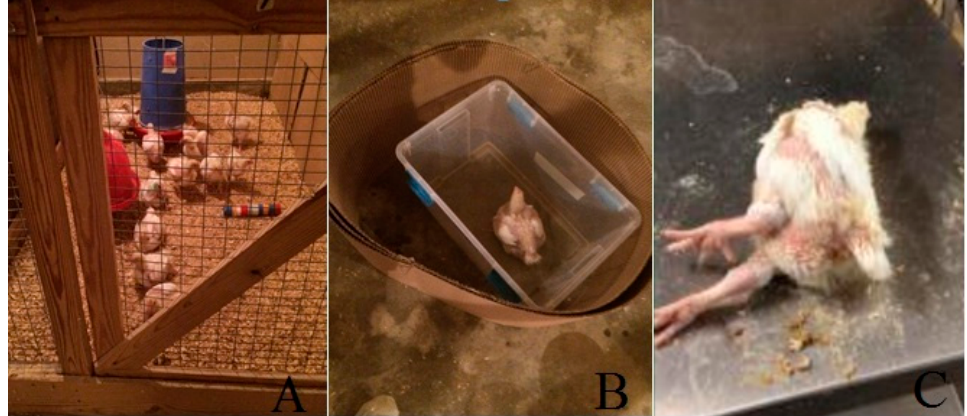
Figure 2. The examples of fear response tests. ( A ) Novel object test; ( B ) isolation test; and ( C ) tonic immobility test.